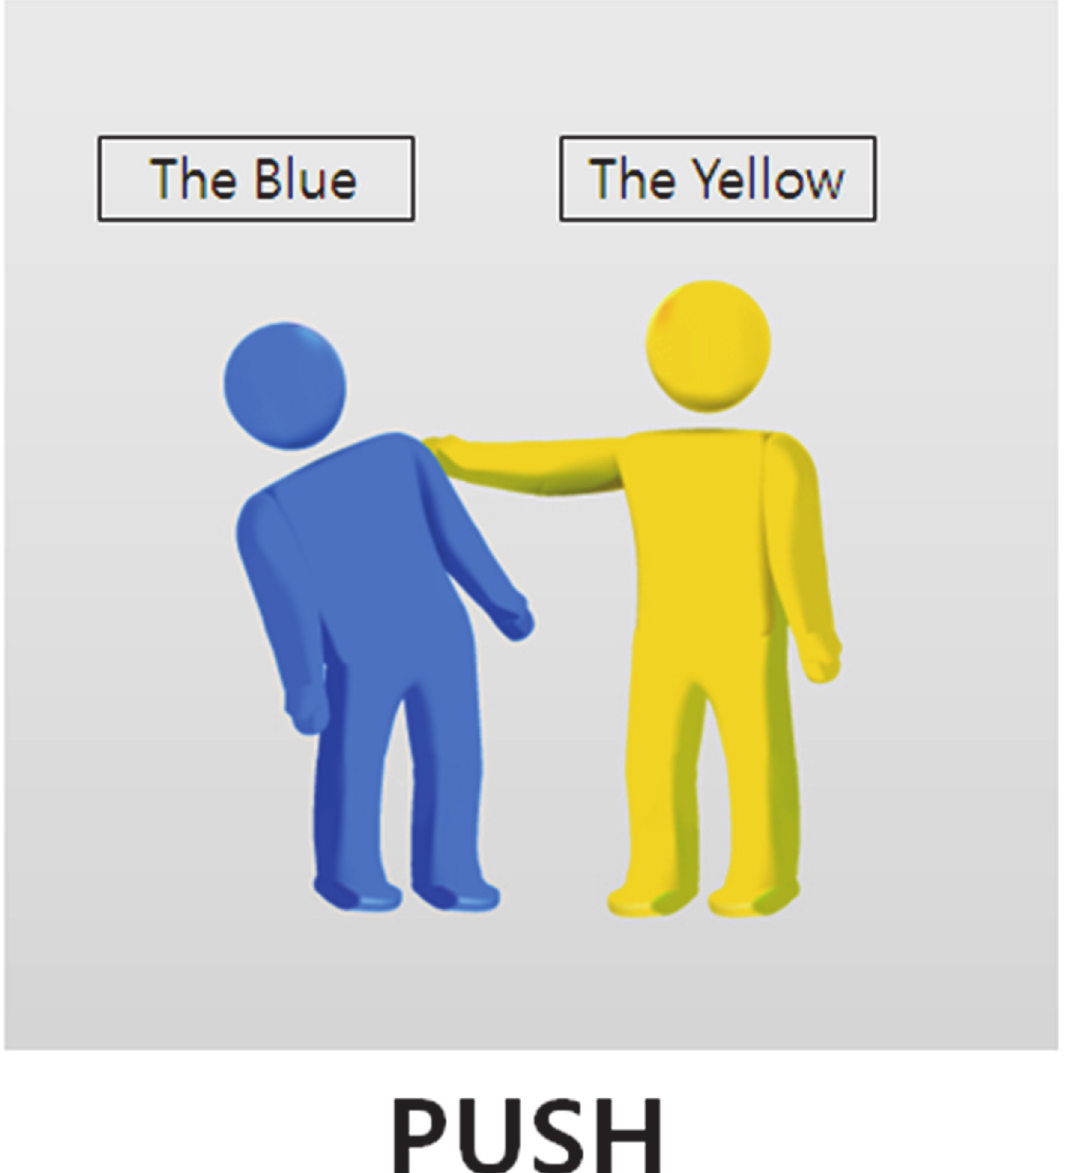
Fig 3. An example of a sentence completion